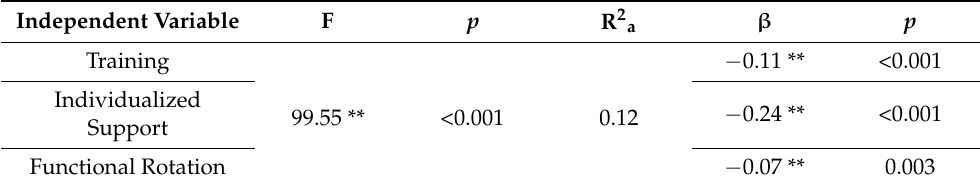
Table 2. Multiple linear regression results